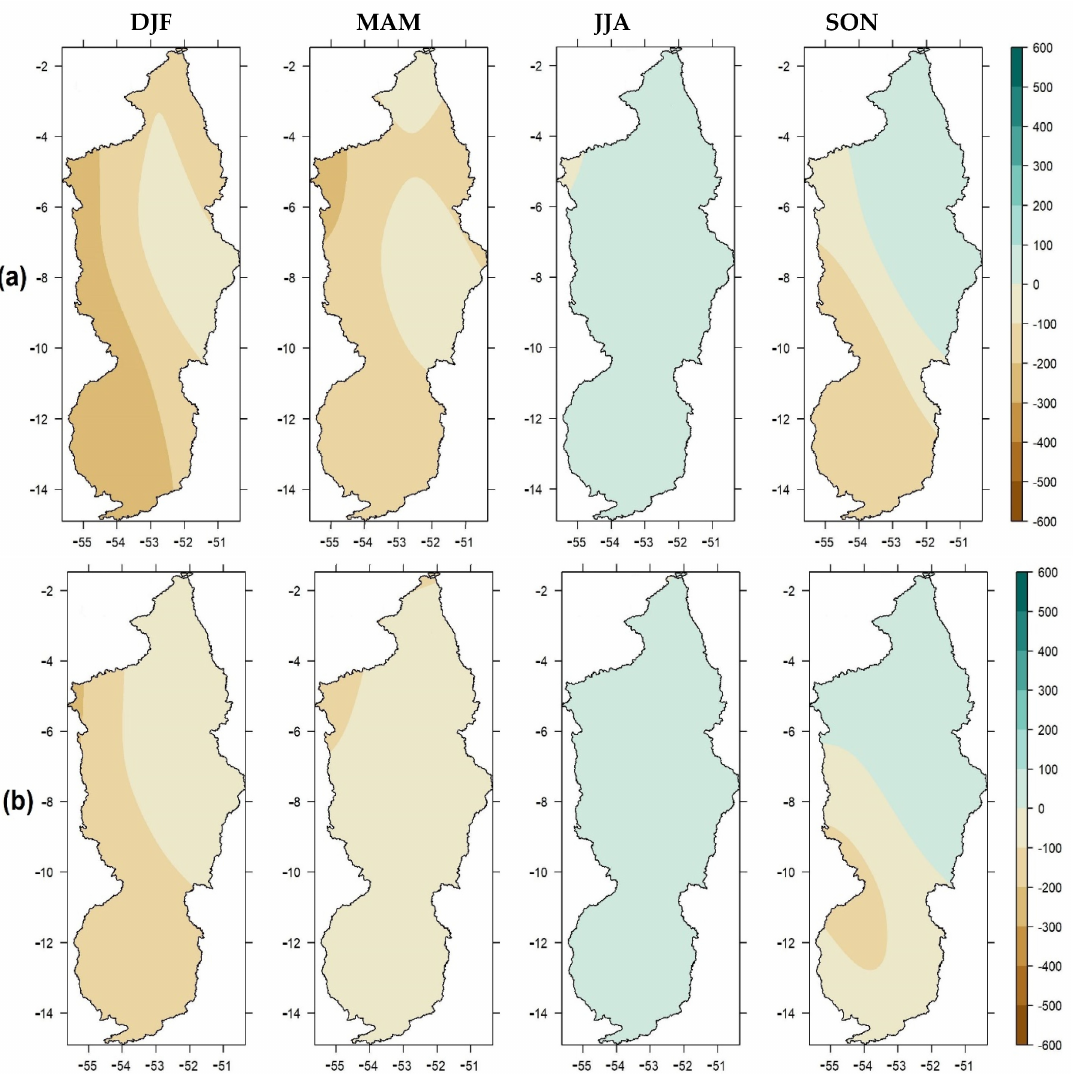
Figure 6. Projected seasonal deviations in the precipitation over the XRB, in mm/period, for the 2021–2050 period, according to the RCP 4.5 ( a ) and RCP 8.5 ( b ) scenarios.